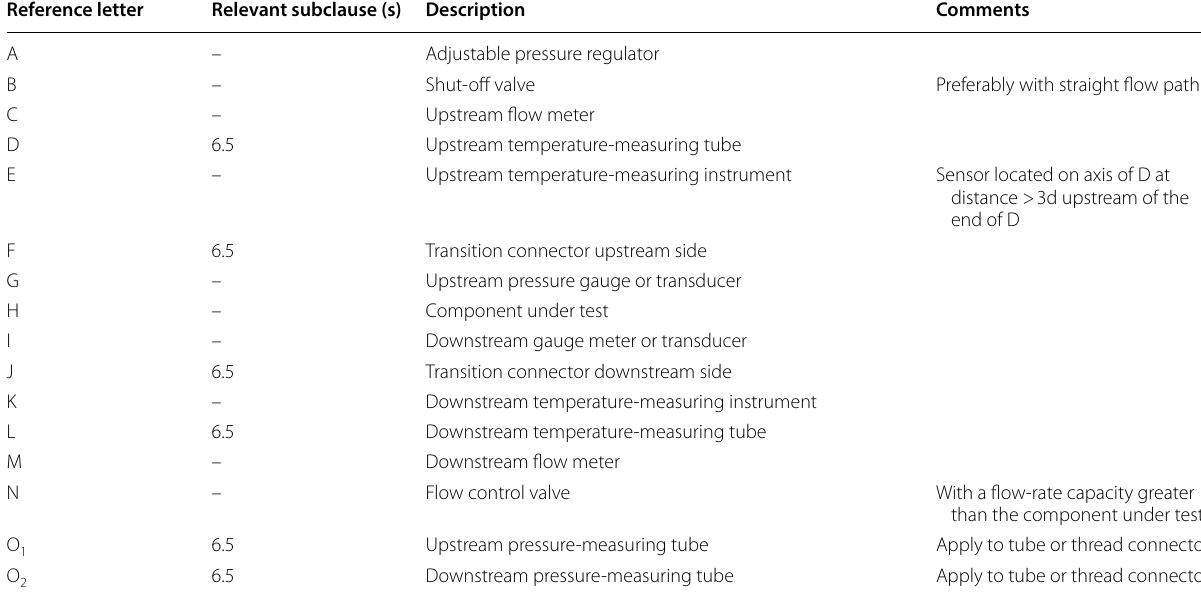
Items A to M are essential and the remaining N, O are chosen by the person conducting the test to suit the prevailing